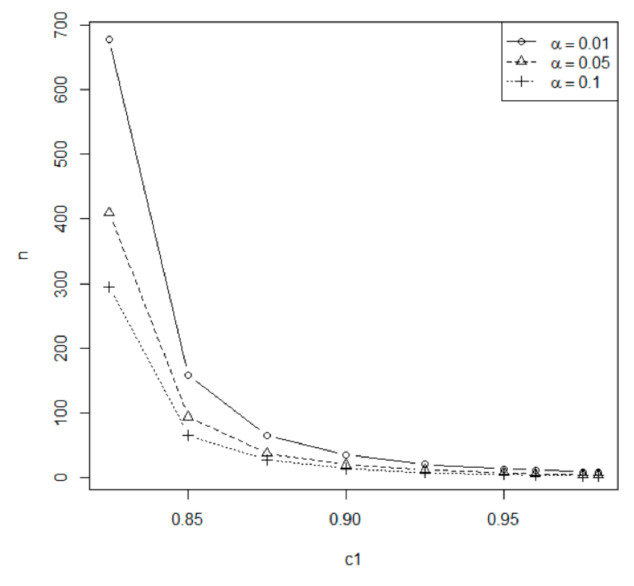
Figure 4. Minimum sample size for the test at β = 0.2 under p = 0.05 and m = 5.